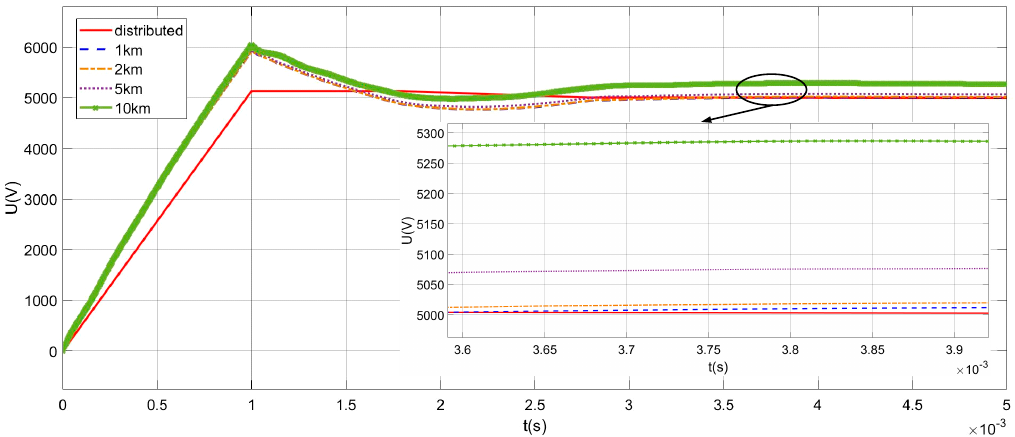
Figure 4. The simulation results of different submarine cable models.